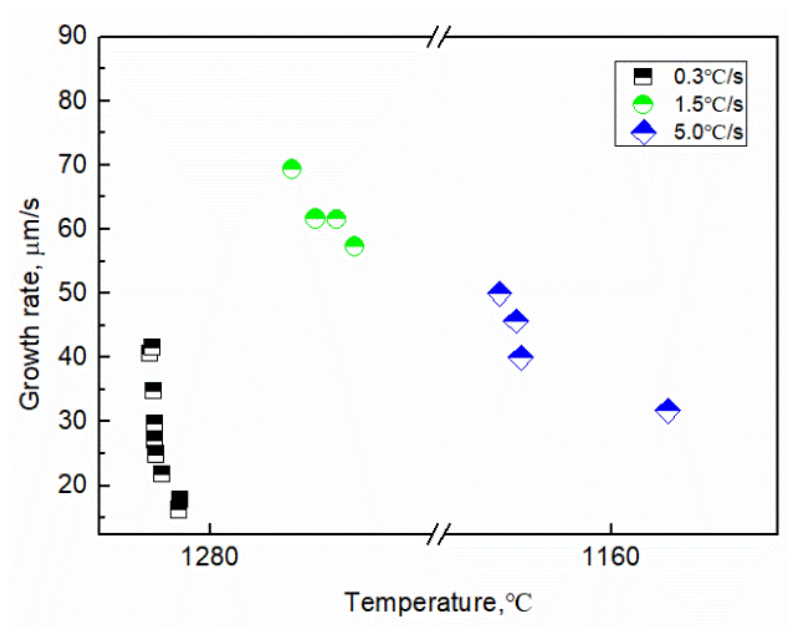
Figure 8. Image analysis results of the growth rate of the γ -Fe dendrite with undercooling.